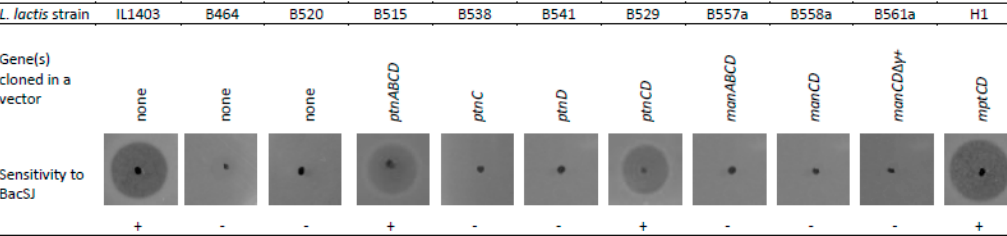
Figure 3. Restoration of BacSJ sensitivity of L. lactis Δ ptnABCD ( L. lactis B464) by Man-PTS compounds from different species. The deleted ptnABCD operon in L. lactis B464 was complemented by expressing genes encoding indicated Man-PTS components from different species ( ptnABCD from L. lactis , manABCD from L. garvieae , mptCD from L. monocytogenes ). L. lactis IL1403 and B520 are control strains either wild-type or with ptnABCD -deletion carrying an empty vector. The genetic features of modified strains are described in Supplementary Table S1.